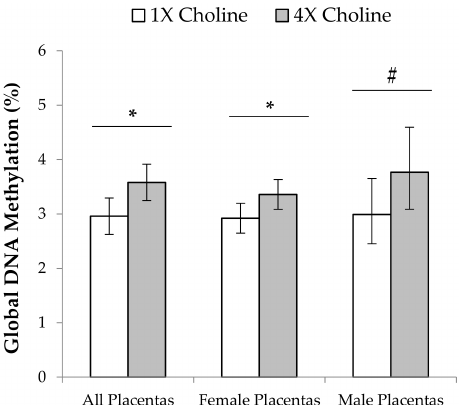
Figure 3. Percentage of global DNA methylation in the placentas from dams in the 1X and 4X choline groups. One placenta (either male or female) from each dam ( n = 3 dams per treatment, per fetal sex) was used, and each placenta was considered to be a statistical unit in the statistical analysis. Data were first analyzed without stratification by fetal sex and then separately for each fetal sex using one-way ANOVA. Results are presented as means with 95% confidence intervals. * p ≤ 0.05. # p =